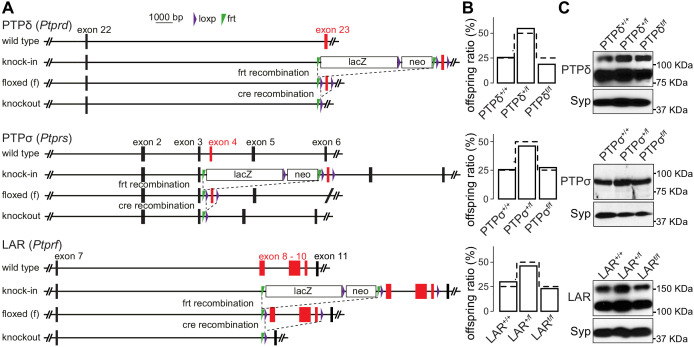
LAR-RPTP conditional knockout mice.(A) Gene targeting strategies for LAR-RPTP conditional knockout mice. PTPδ and PTPσ alleles contain loxP sites flanking exons 23 and 4, respectively. They were imported for cryo-recovery at the ‘knock-in’ stage from the Welcome Trust Sanger Institute (Ptprdtm2a(KOMP)Wtsi) and the Canadian Mouse Mutant Repository at the Hospital for Sick Children (C57BL/6N-Ptprstm1a(KOMP)Mbp/Tcp) and are identical to the alleles described before (Bunin et al., 2015; Farhy-Tselnicker et al., 2017; Sclip and Südhof, 2020). The LAR allele contains loxp sites flanking exons 8, 9, and 10 and was obtained at the embryonic stem cell stage from the Helmholtz Zentrum München (Ptprftm1a(EUCOMM)Wtsi). Each of the three lines was crossed to flp-transgenic mice (Dymecki, 1996) to generate individual ‘floxed’ conditional knockout alleles. (B) Survival analyses were performed on the offspring of heterozygote matings for each individual floxed allele. Offspring ratios were assessed at >P14. Bars show the percentage of offspring for each genotype, and dotted lines represent the expected Mendelian ratio. N (PTPδ)=28 mice/4 litters; N (PTPσ)=31/4; N (LAR) = 22/3. Chi-square tests were used to compare expected Mendelian ratios with obtained offspring ratios, and no statistical difference was detected. (C) Western blots of whole brain homogenates of wild-type, heterozygous and homozygous littermate mice for the PTPδ, PTPσ, and LAR floxed alleles. For PTPδ, ~80 kDa and ~120 kDa bands were detected, matching the cleaved extracellular domains of the two main isoforms expressed in the brain containing three immunoglobulin and either four or eight fibronectin domains (Shishikura et al., 2016). For PTPσ, a single band at ~90 KDa was detected, matching the size of the catalytically cleaved extracellular domain of the short isoform containing four fibronectin domains and three immunoglobulin domains (Aicher et al., 1997). For LAR, ~110 kDA and ~150 KDa bands were detected as previously described in the hippocampus (Yang et al., 2003). The bigger band matches the cleaved extracellular domains of the longest isoform containing three immunoglobulin and eight fibronectin domains (Aicher et al., 1997), while the smaller band likely corresponds to a shorter isoform. In cultured hippocampal neurons, only the higher intensity bands at the lower molecular weight were detected, and these bands were effectively removed after cre-recombination of the floxed alleles (Figure 1B).